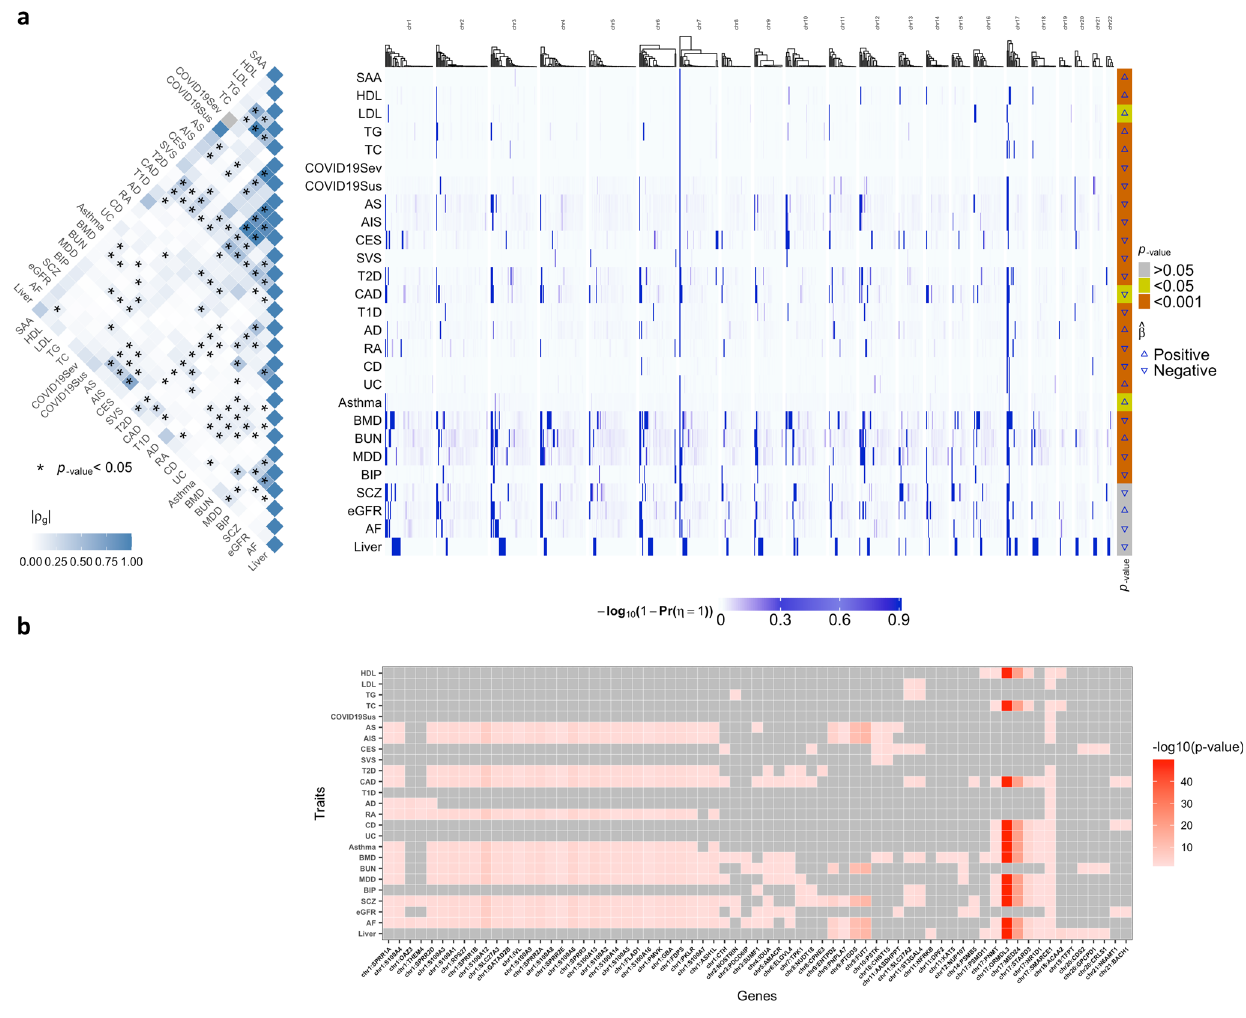
Fig. 3 | MR-CUE analysis of IL-6 on multiple traits/diseases. a (Left panel) The heatmap of the estimated genetic correlations ( ρ g ) among the 27 examined out- comes with IL-6 as exposure. The genetic correlation p -values are from two-sided LDSCtests 28 withoutmultipletestingadjustment.(Rightpanel)Theheatmapofthe estimated strengths of CHP, (cid:2) log 10 ð 1 (cid:2) Pr ð η l =1 ÞÞ , for selected IVs across all chromosomes for the 27 outcomes. The p -values on the right bar indicate the signi fi cance of the causal effects of IL-6 on the examined outcomes, and are from